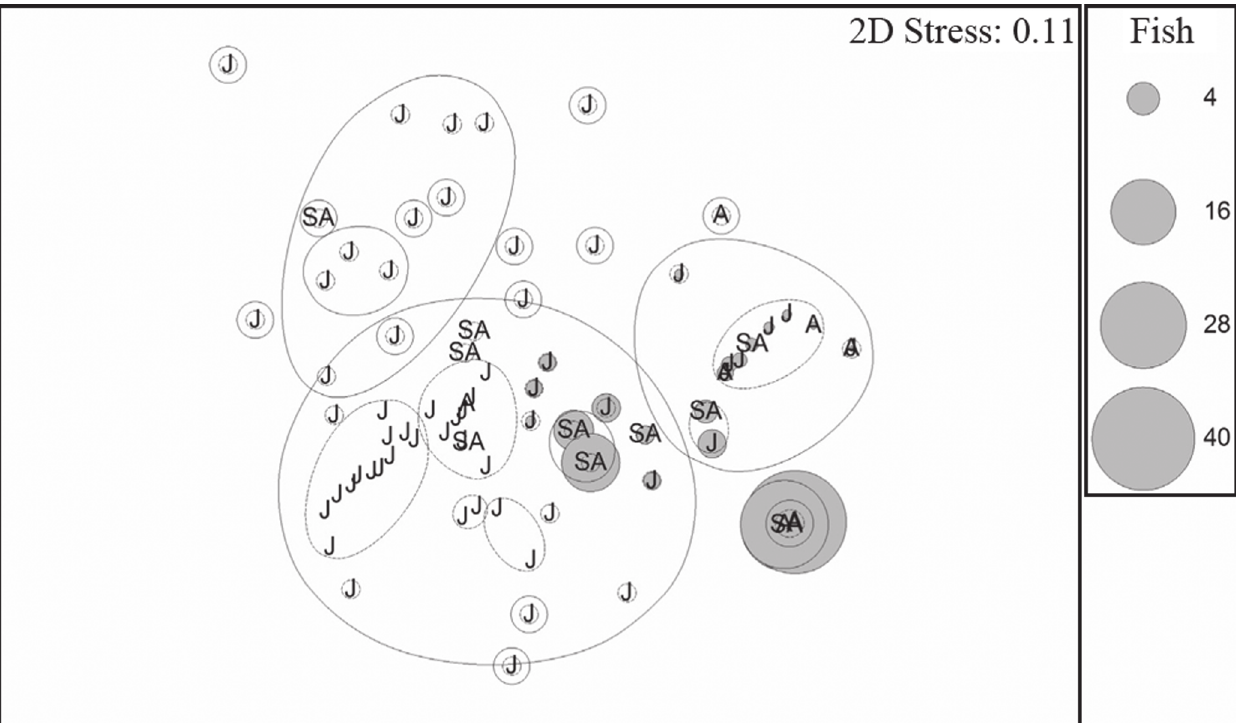
Fig. 4. Contribution of the food item Fish to the Lutjanus analis diet, from Abrolhos Bank coral reefs, Eastern Brazil, between June 2005 and March 2007. The larger the bubble, the greater the percent participation of volume. J = juveniles; SA = sub- adults; A =